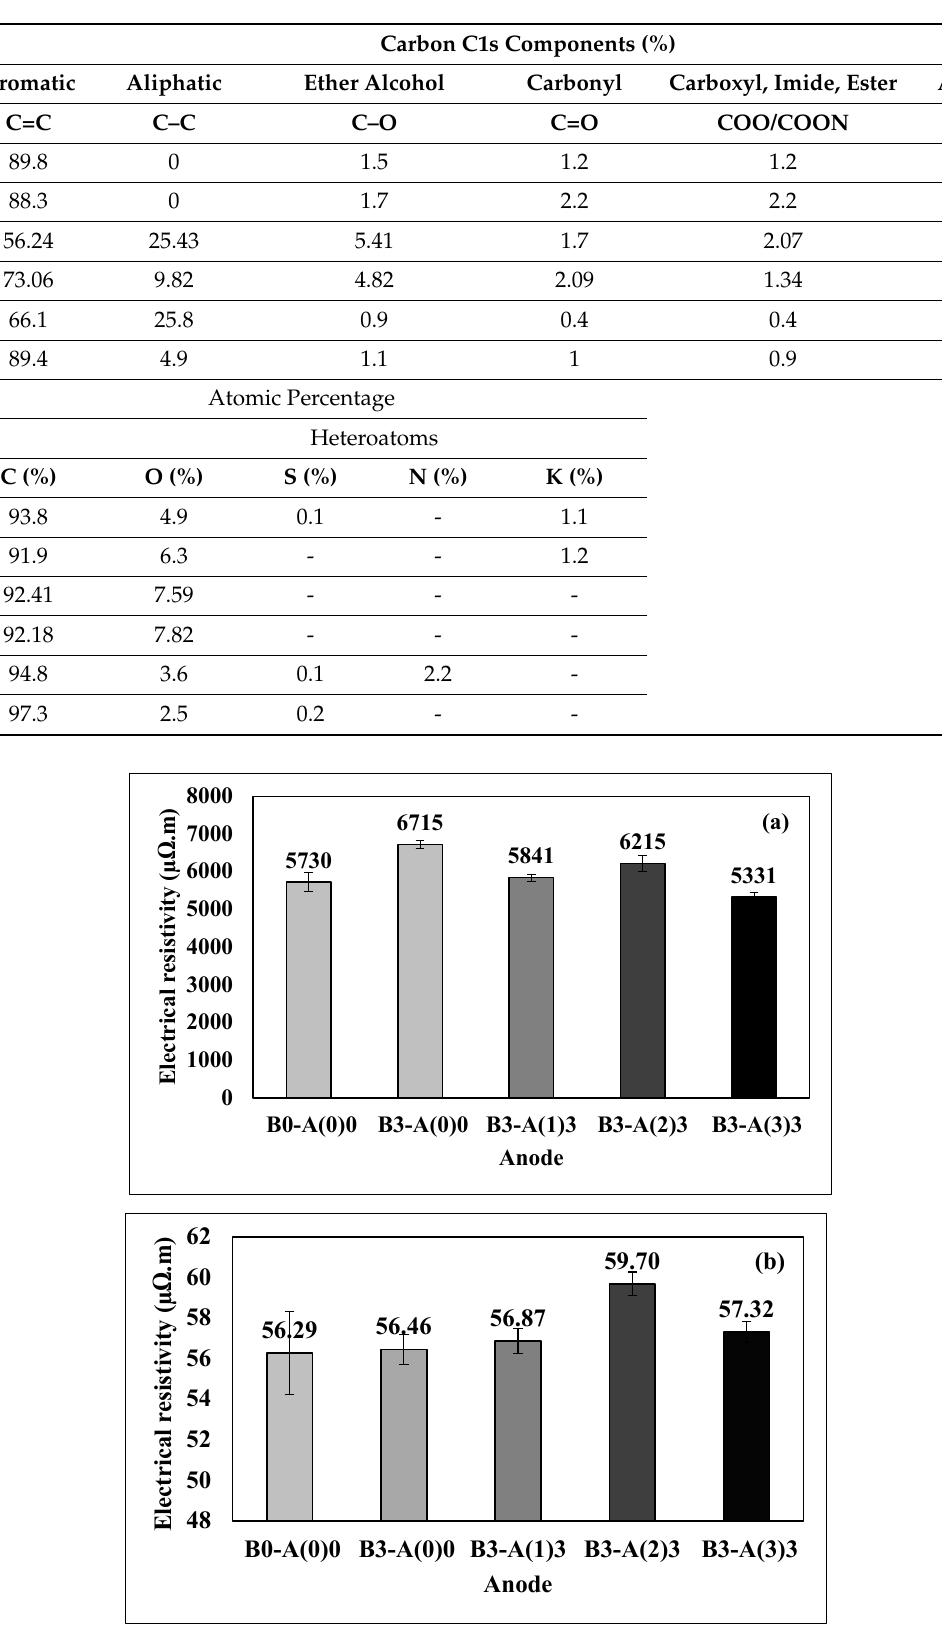
Table 3. Atomic percentages of the coke, pitch, and unmodified/modified biocokes.